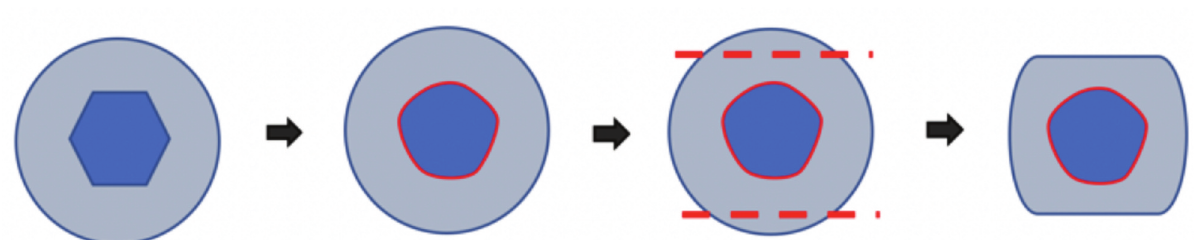
Diagram depicting a screw head that becomes damaged at the hexagonal recess; dotted lines show the straight and parallel Fig. 3: planes created using a high speed diamond-tipped